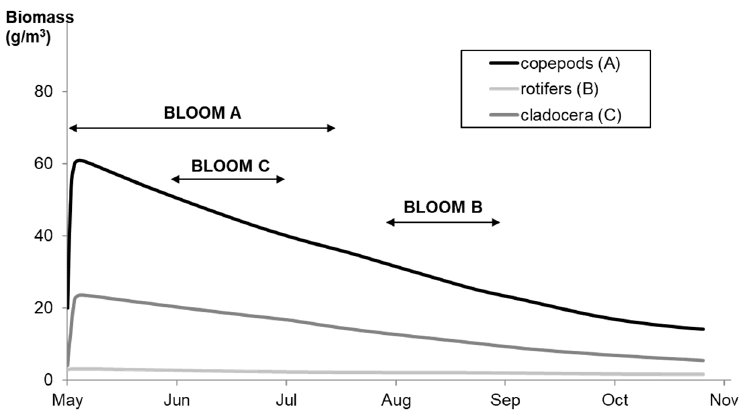
Figure 10. Simulation results for zooplankton (lines) with the anticipated blooms added (blocks; legend: (A) copepods (B) rotifers and (C) Cladocera).